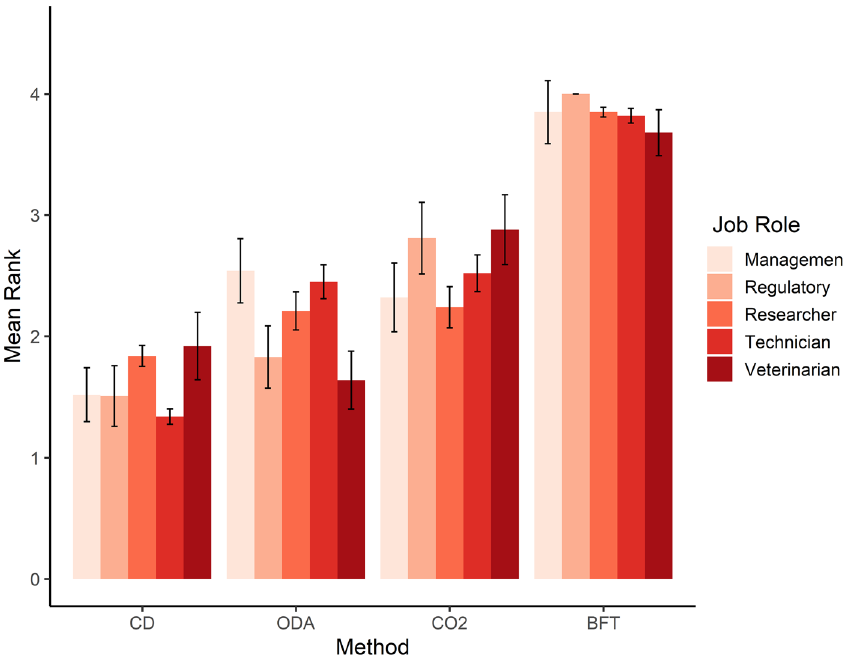
Figure 4. Mean ranking order (between 1 and 4 with 1 being most preferred and 4 being least preferred) of individual preference for each schedule 1 method according to current job role, BFT = blunt force trauma, CD = Cervical dislocation, CO 2 = exposure to carbon dioxide, ODA = overdose of anaesthetic.